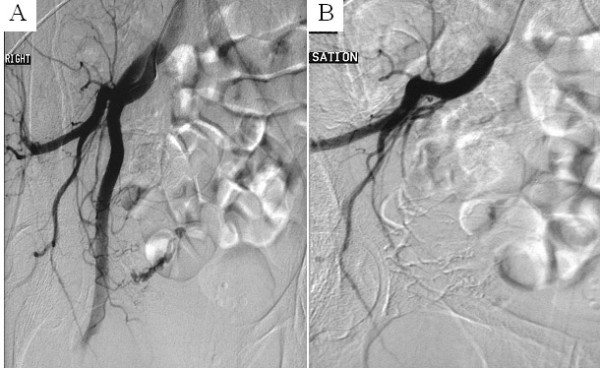
Angiography post transurethral resection of bladder tumour. A, Pre-embolisation. B, Post-embolisation of anterior division of internal iliac artery.